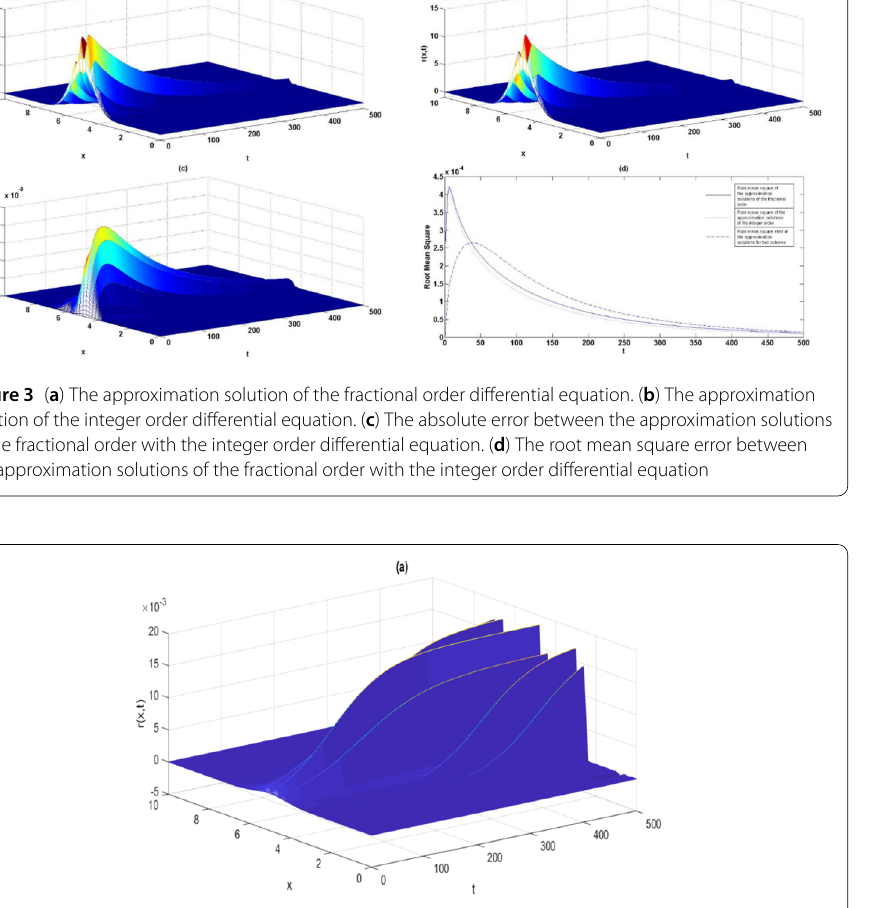
the free virus density r ( x , t ). For a short time period, lower fractional order solutions dif- fuse more slowly; however, as time increases the diffusion phenomena become